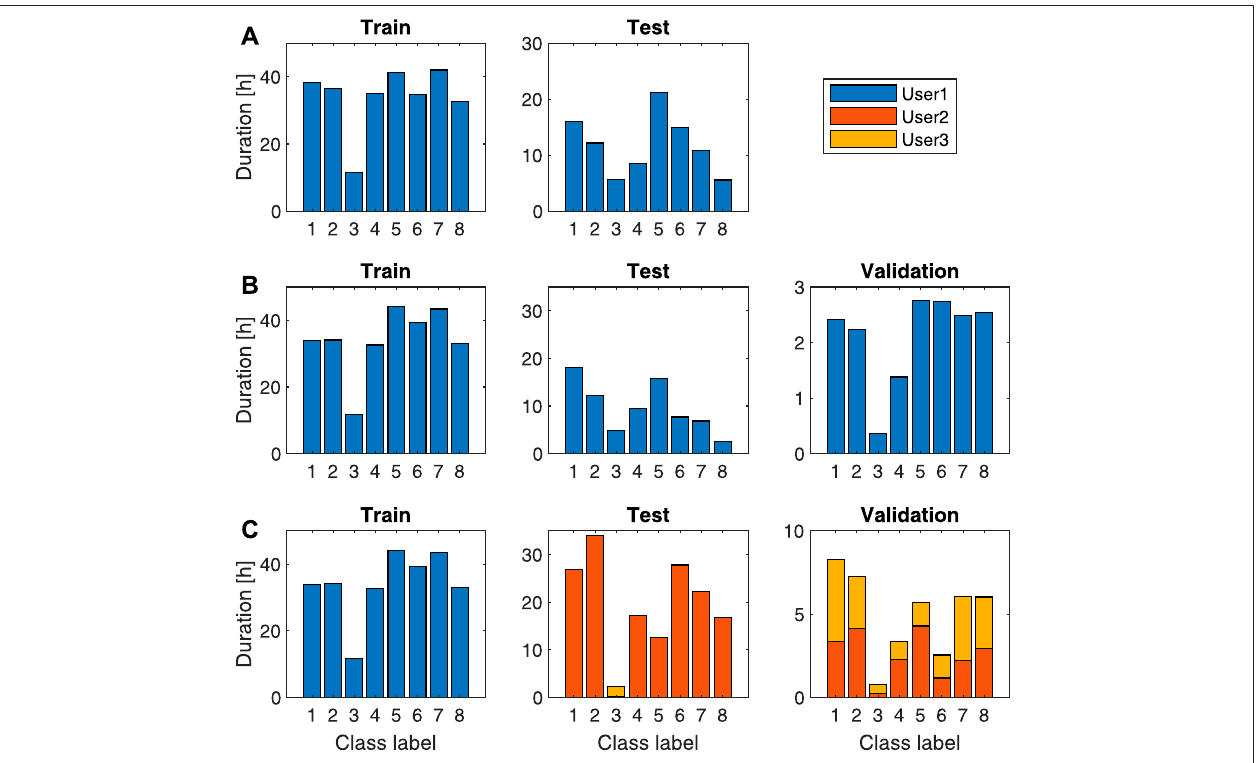
FIGURE 5 | Amount of data for each of the eight transportation activities for the three challenges. (A) SHL 2018. (B) SHL 2019. (C) SHL 2020. The eight class activities are: 1 — Still; 2 — Walk; 3 — Run; 4 — Bike; 5 — Car; 6 — Bus; 7 — Train; 8 —